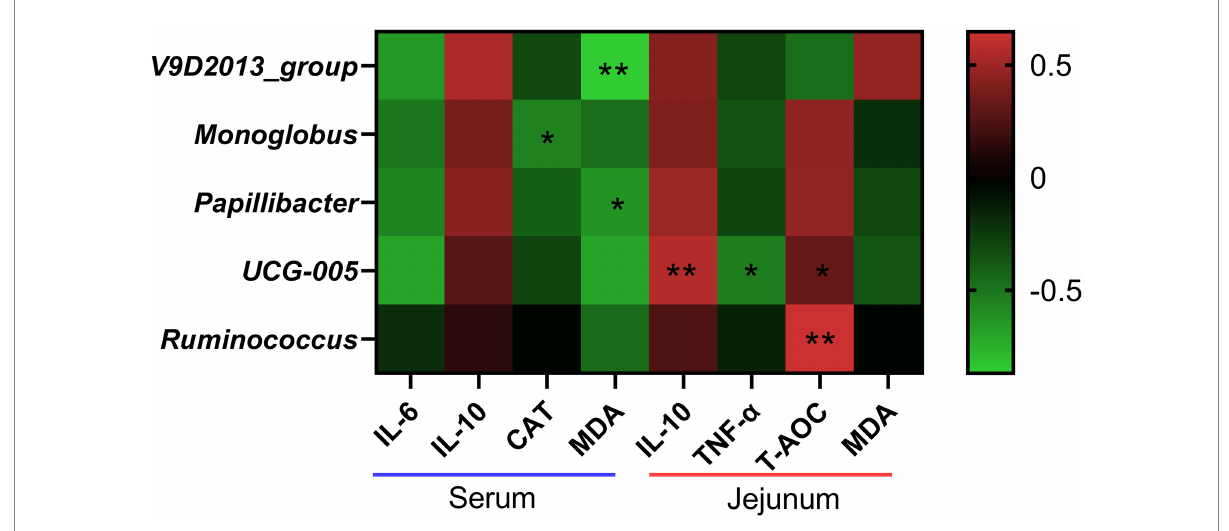
FIGURE 9 Correlation analysis between the abundances of differential bacteria at genus level and the levels of inflammatory cytokines and antioxidant indices. IL-6, interleukin 6; IL-10, interleukin 10; CAT, catalase; MDA, malondialdehyde; TNF- α , tumor necrosis factor-alpha; T-AOC, total antioxidant capacity. *the correlation is significant at a level of 0.05. **the correlation is significant at a level of